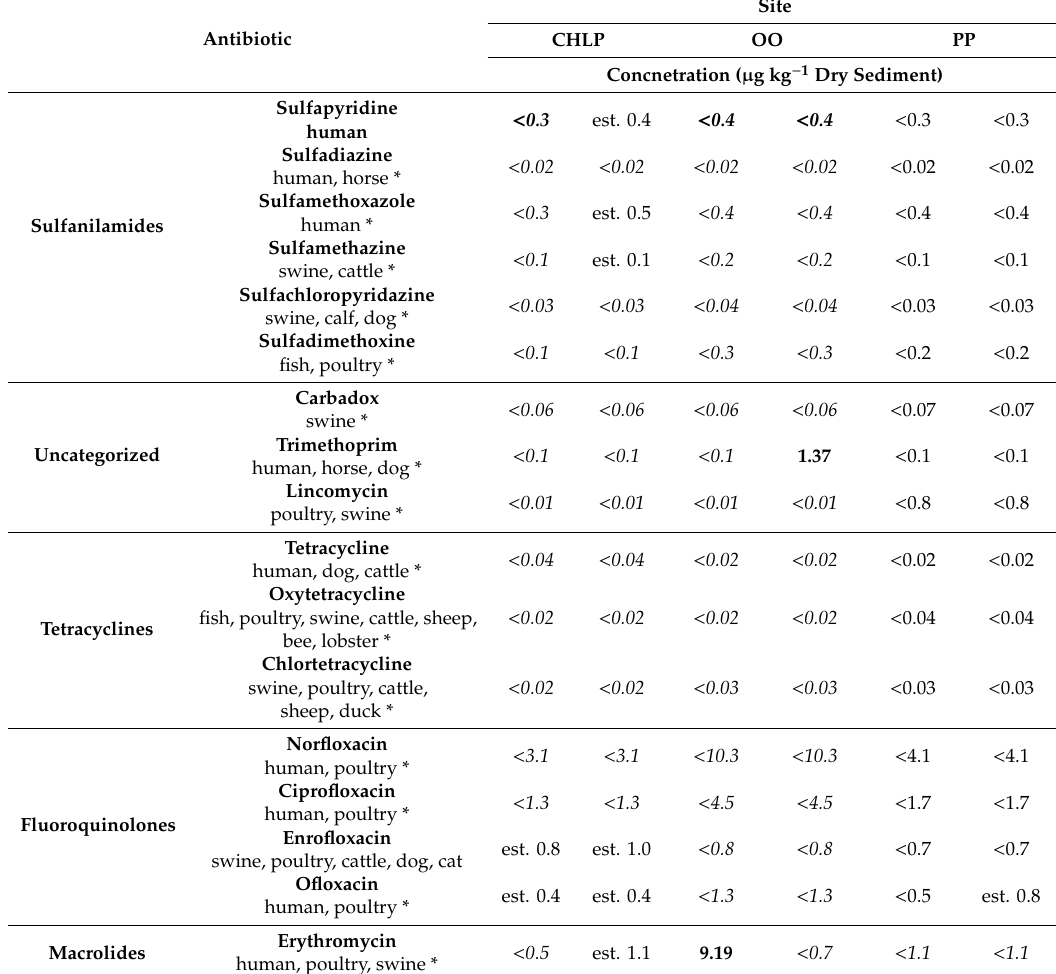
Table 1. Concentration of antibiotics detected in agricultural floodplain sediment samples. Values below these detection limits are reported as < DL and italicized in gray font. Values below the limit of quantification are provided as estimates (est.). Readings that were quantifiable are